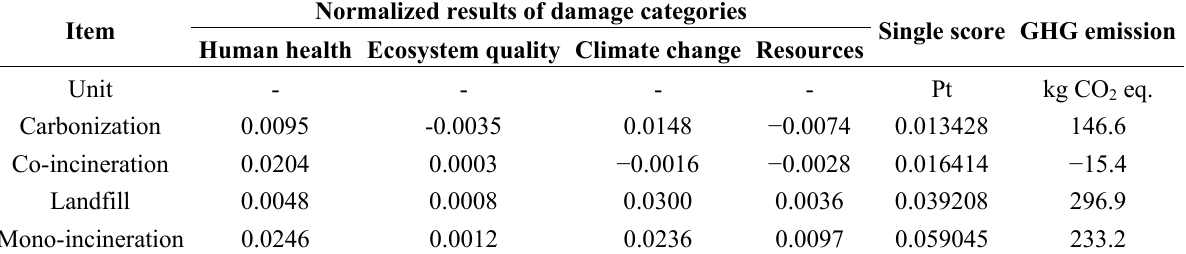
Table 3. Results of normalization, single score, and GHG emission in